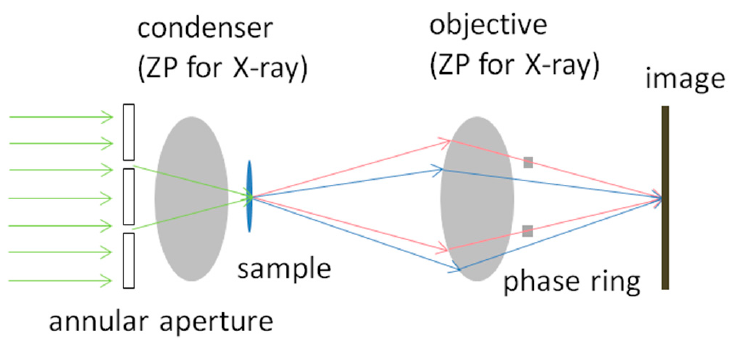
Figure 1. Sketch of Zernike’s phase-contrast microscope. sample, part of the light is diffracted by the sample, as indicated in blue. The undiffracted light, which is indicated in red, forms the background on the image plane. Typically, diffracted light has a − 90 ◦ phase shift compared with undiffracted light. Without the phase ring, the interfered waves show intensities similar to the background; thus, the interference patterns in the detector exhibit low imaging contrast, as shown in Figure